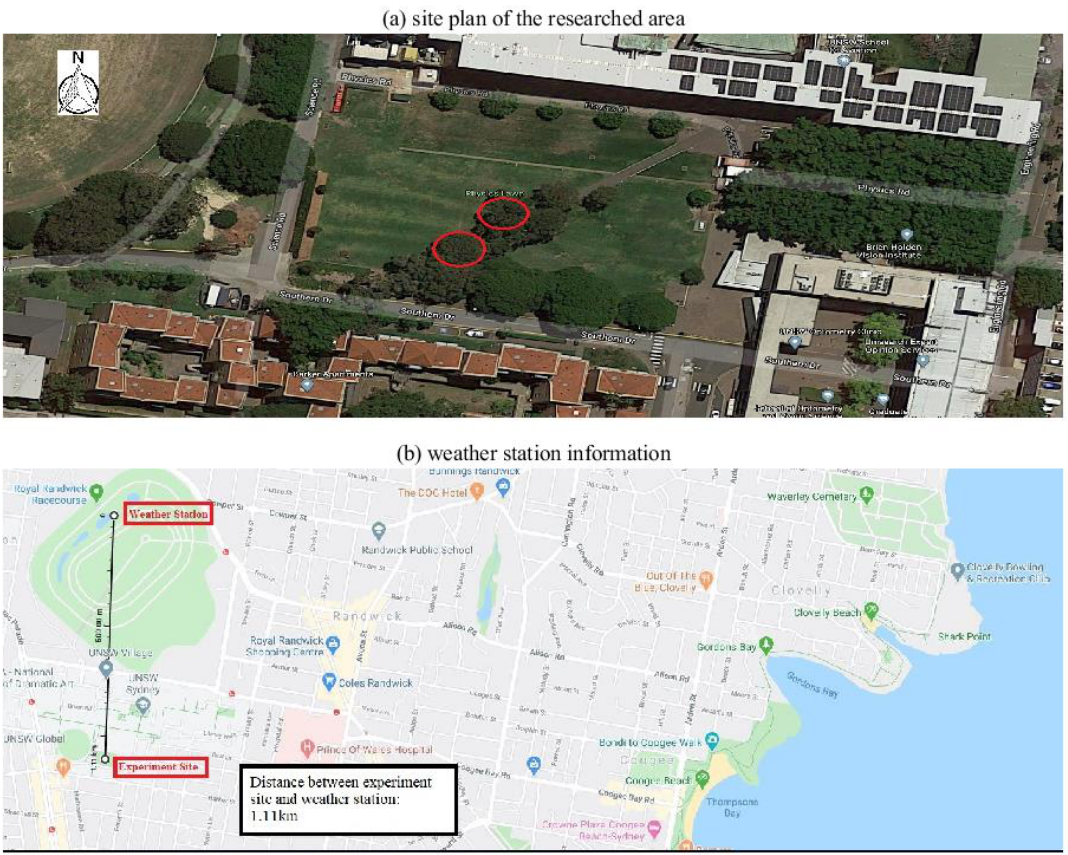
Figure 1. ( a ) site plan of the studied area; the red circles are the canopies of the researched trees. ( b ) weather station information.